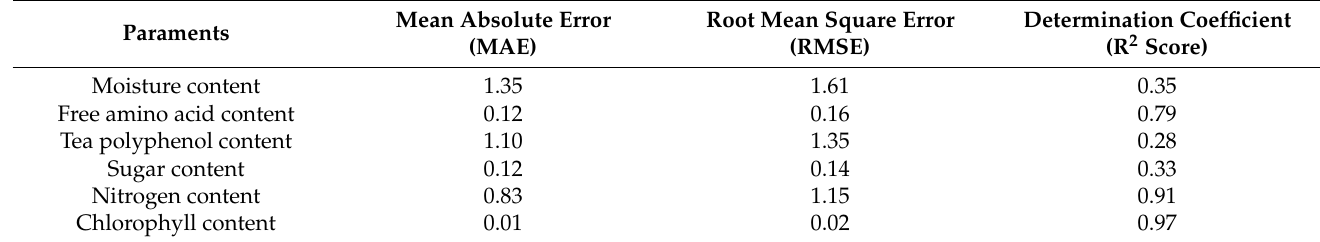
Table 6. Accuracy evaluation table of prediction results.